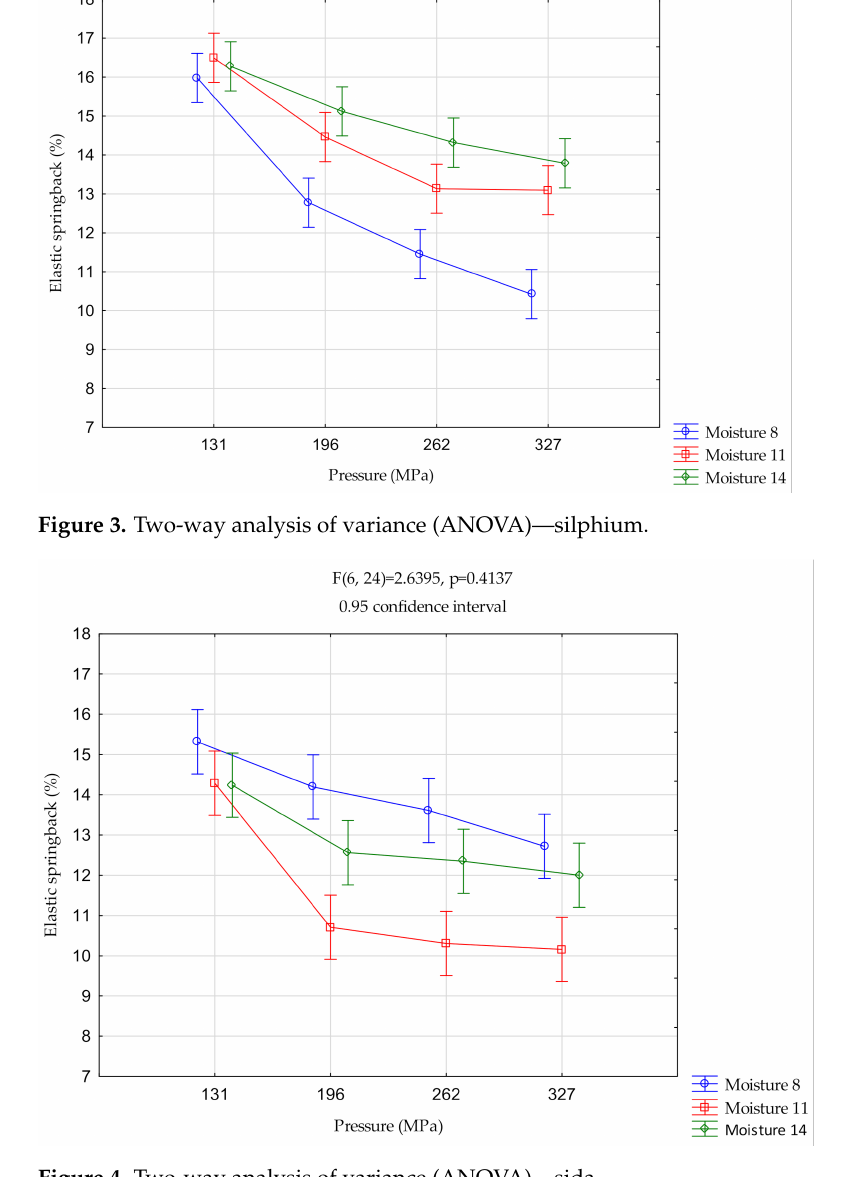
Figure 4. Two-way analysis of variance